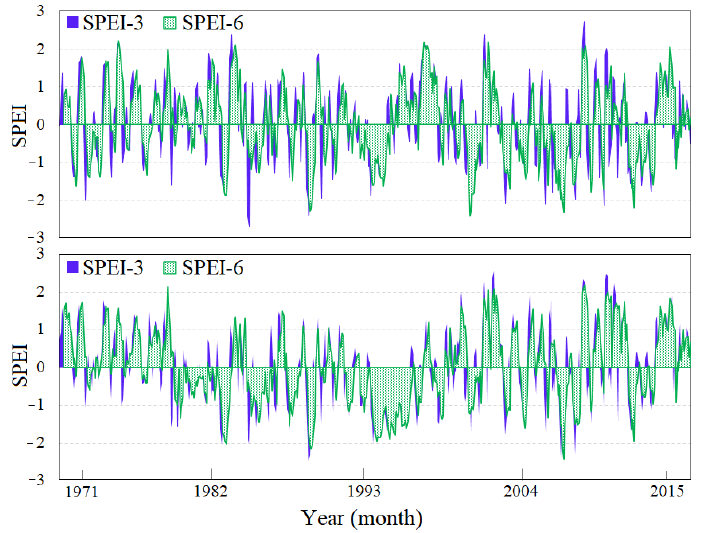
Figure 1. The observed SPEI series at Beypazari (upper panel) and Nallihan stations (lower panel).